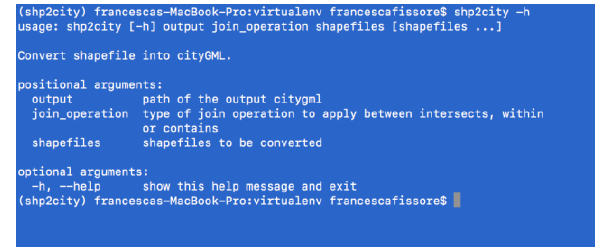
Figure 2. The help menu of shp2city.